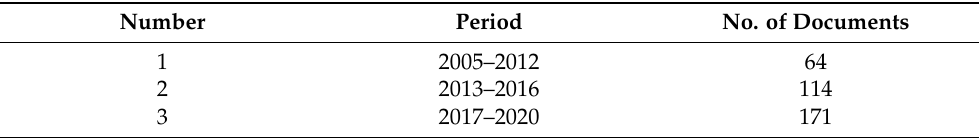
Table 1. Periods and number of documents per